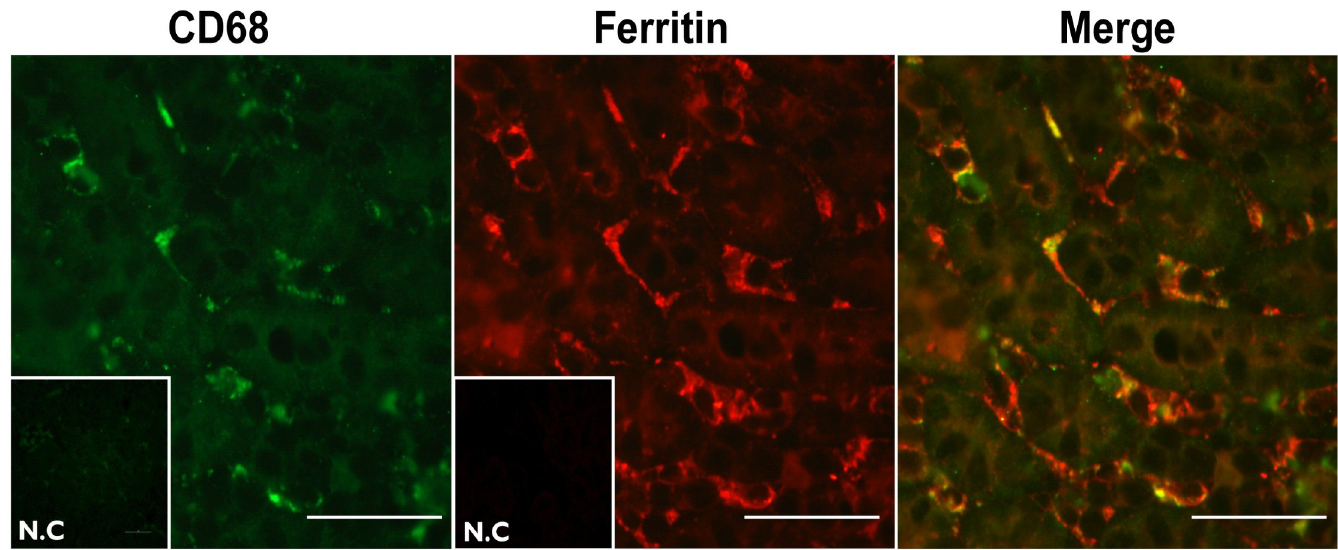
Fig 7. Ferritin accumulated in medullary interstitial macrophages: Kidney sections from PIO mice were co-stained with anti-CD-68 and L-ferritin antibodies. Co-localization can be observed as yellow regions in the right panel. Scale bar represents 50 μ m.